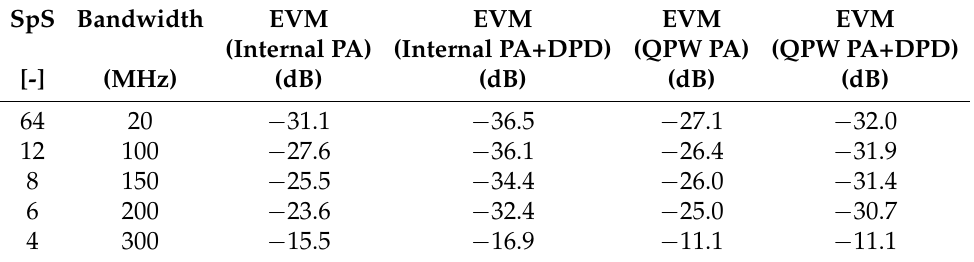
Table 8. EVM with and without digital predistortion for 16 QAM as a function of samples per symbol